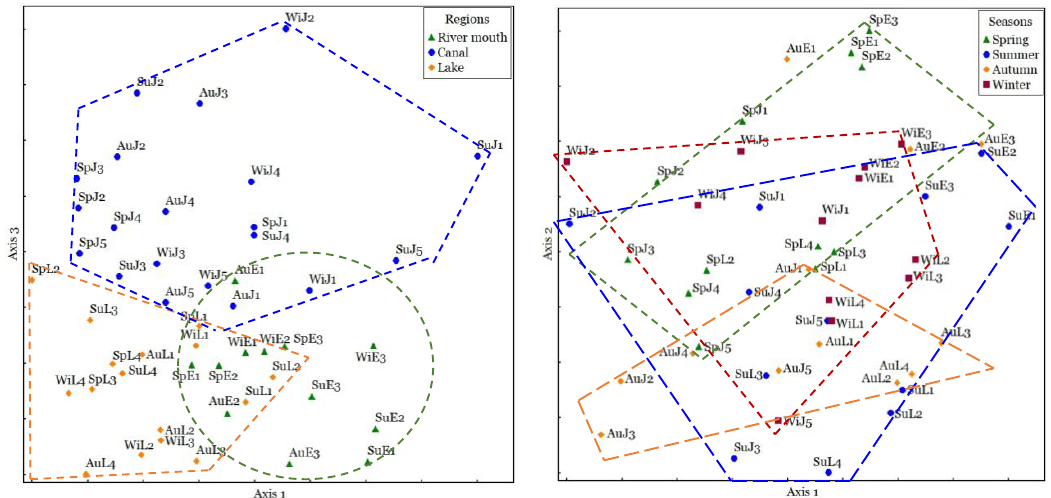
Figure 3. Non-metric multidimensional scaling (NMDS) ordination of macroinvertebrates samples over 4 seasons and 3 regions. Table 4. PERMANOVA analysis of macroinvertebrate communities in the Weishan Lake.